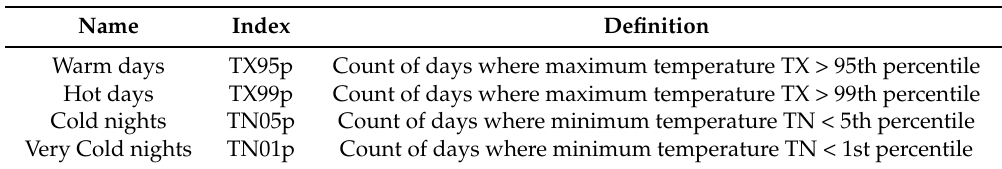
Table 1. Definition of four temperature indices in